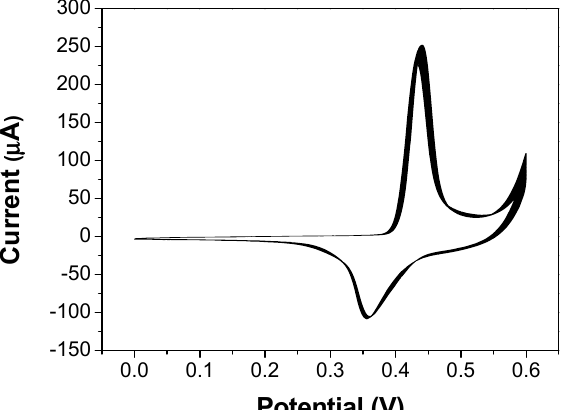
Figure 4. Forty consecutive cyclic voltammograms curves of the N-rGO nanohybrid- modified electrode in 0.1 M NaOH solution at a scan rate of 0.1 Vs − 1